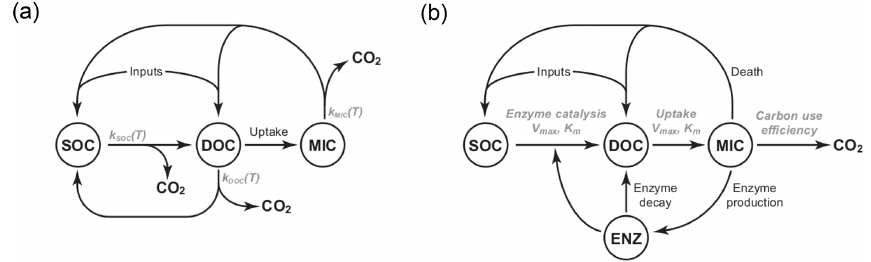
Figure 1. Diagrams of the pool structures of the (a) CON model and (b) AWB model drawn from Allison et al. (2010). Pools are shown within circles including soil organic carbon (SOC), dissolved organic carbon (DOC), and microbial (MIC) pools. AWB has SOC, DOC, and MIC pools as in CON but also an extra enzymatic (ENZ) pool. AWB additionally differs from CON in its nonlinear feedbacks and assumption that MIC can influence SOC-to-DOC turnover through the ENZ